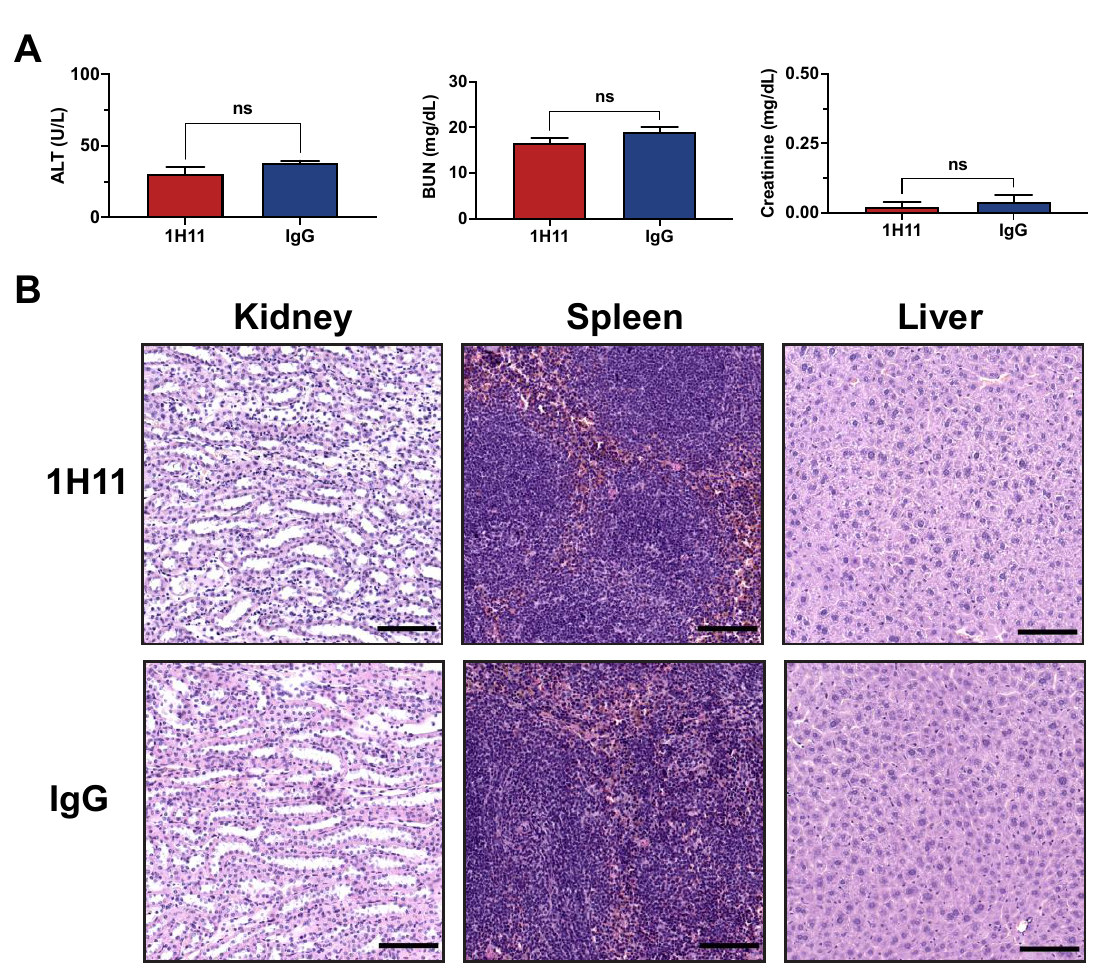
Figure 6. 1H11 does not induce major toxic effects. Athymic nude mice with subcutaneously implanted OVCAR8 tumors were treated for one week with 5 mg/kg 1H11 or IgG. ( A ) Chemistry tests for alanine transaminase (ALT), blood urea nitrogen (BUN), and creatinine were conducted from serum samples. No significant changes were observed between groups. All data plotted as mean ± SEM, non-significant (ns) vs. IgG. ( B ) Kidney, spleen, and liver samples stained with H&E showed no major histological difference. Representative images are shown with a scale bar = 100 µm.